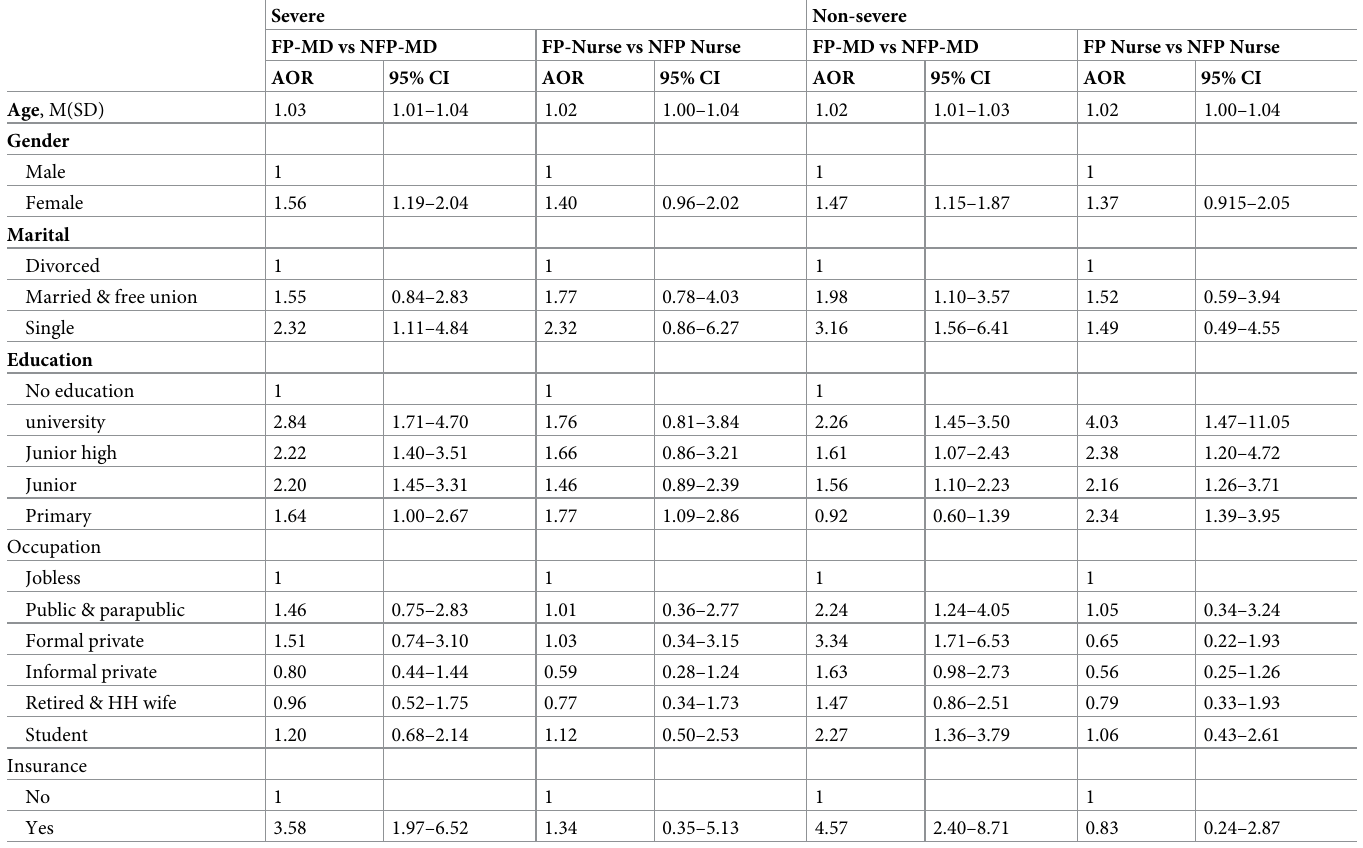
Table 3. Multivariable logistic regression of the choice of providers with same qualification but from different ownership by severity of